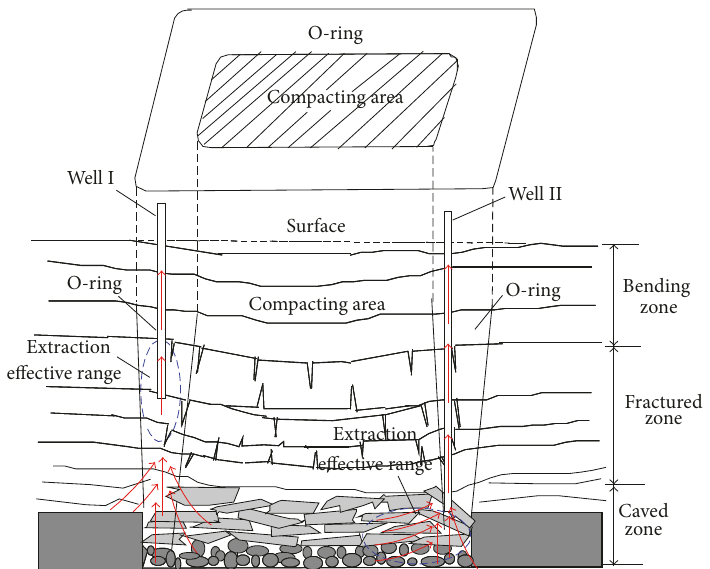
Figure 6: Sketch of different surface well bottom